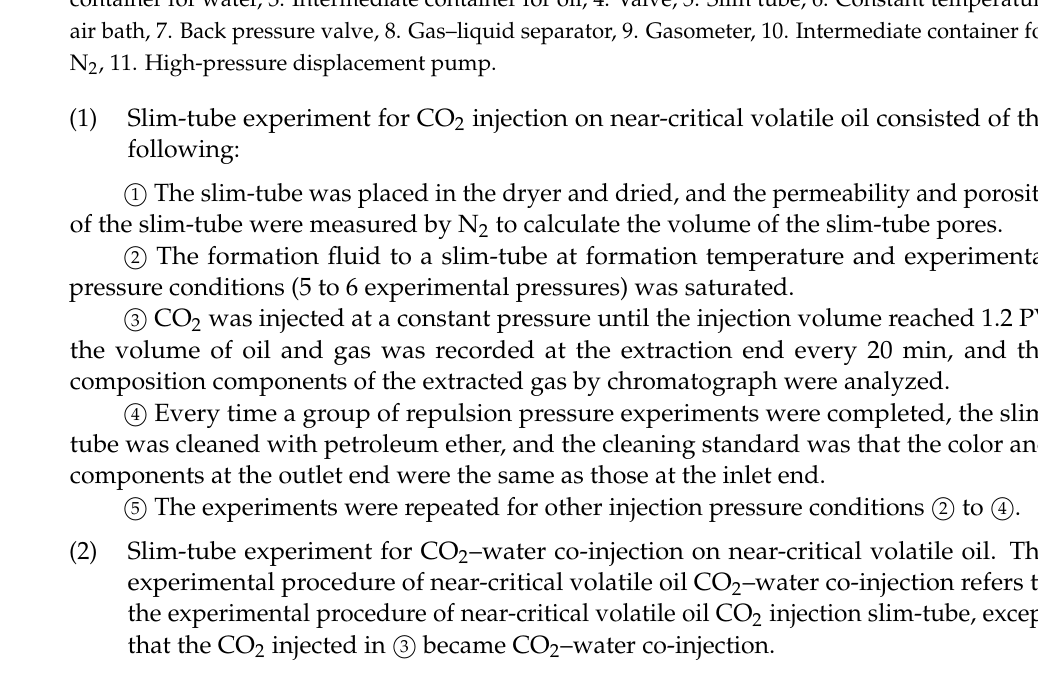
Figure 4. Flow chart of slim-tube experiment: 1. Intermediate container for CO 2 , 2. Intermedi- ate container for water, 3. Intermediate container for oil, 4. Valve, 5. Slim tube, 6. Constant temperature air bath, 7. Back pressure valve, 8. Gas – liquid separator, 9. Gasometer, 10. Intermediate container for N 2 , 11. High-pressure displacement pump.